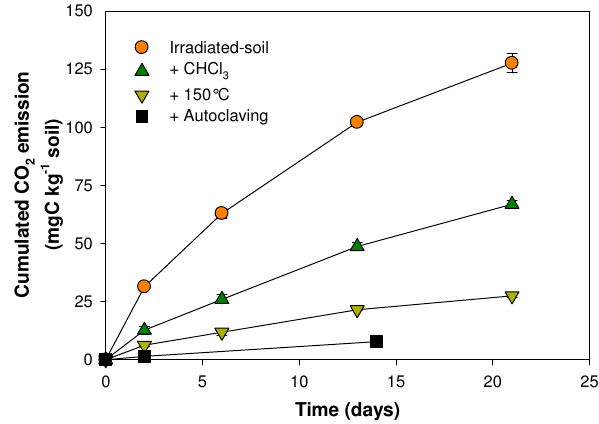
Fig. 6. Cumulated CO 2 emission from the soil from Theix af- ter exposure to irradiation (Irradiated-soil), irradiation and 150 ◦ C ( + 150 ◦ C), irradiation and chloroform fumigation ( + CHCl 3 ), and irradiation and autoclaving ( +